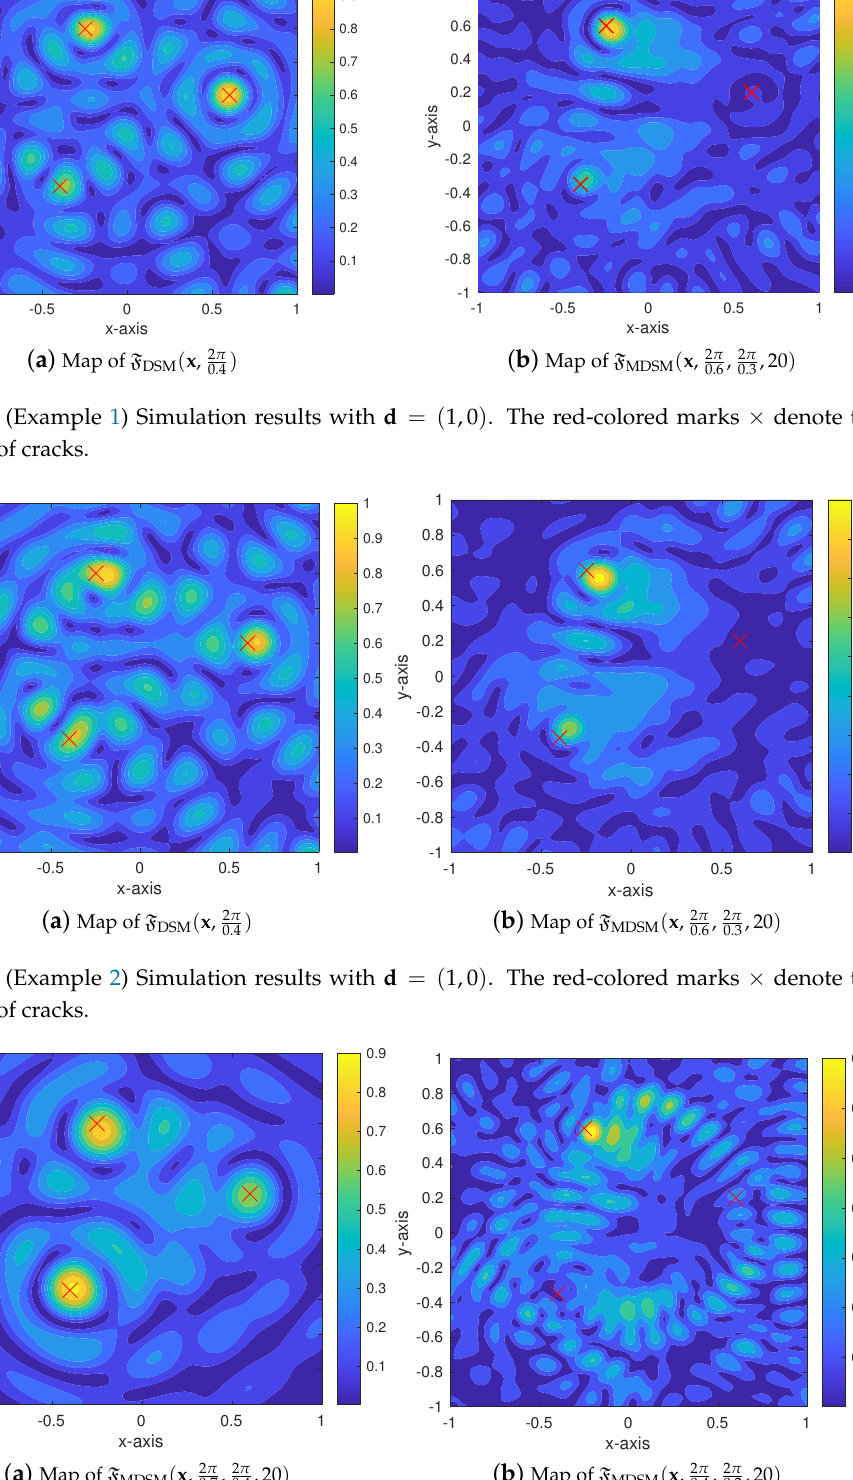
Figure 5. (Example 3) Simulation results with d = ( 1,0 ) . The red-colored marks × denote the locations of